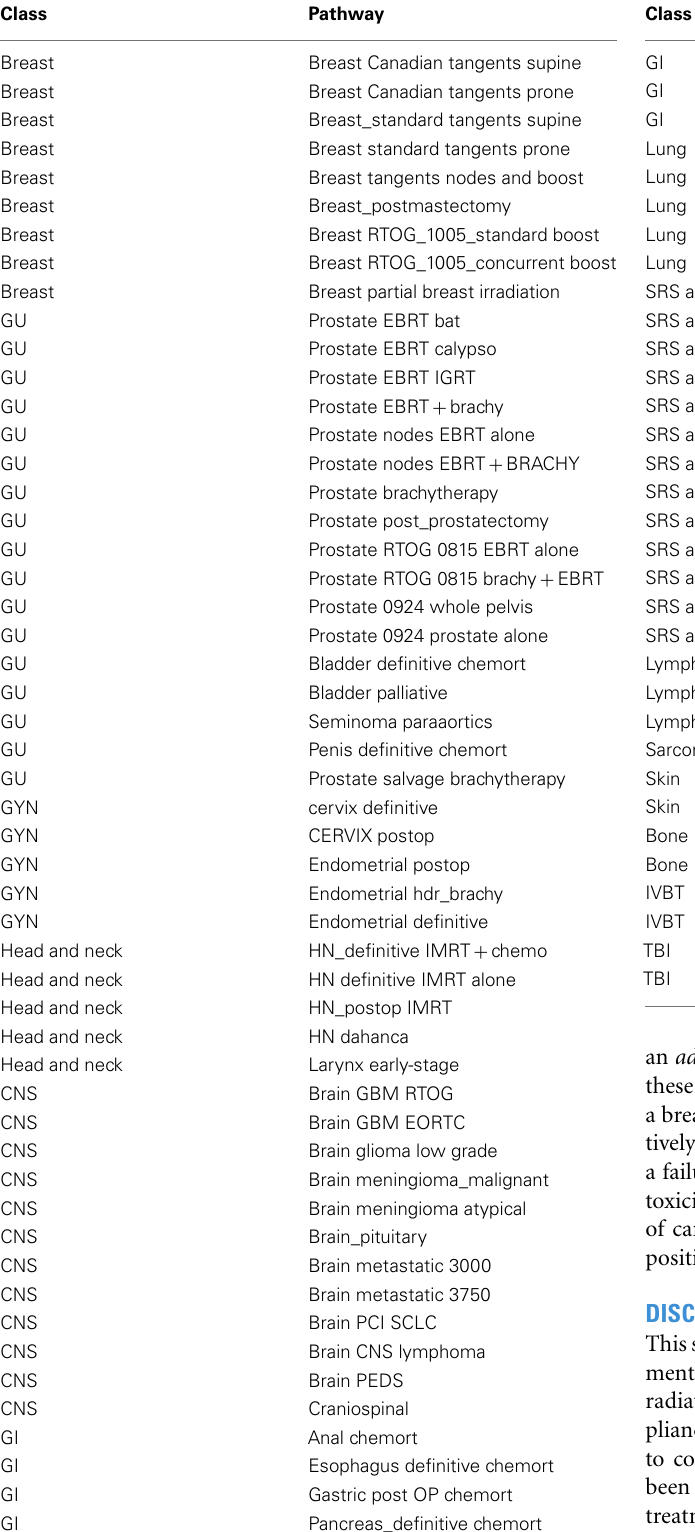
Table 1 | Current library of treatment pathways in use at North Shore-LIJ Health